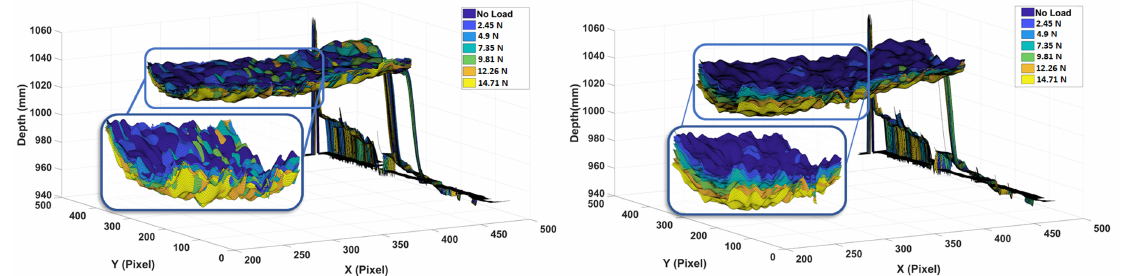
Figure 12. Wing deflections due to loads placed at ( Left ) Position 1 ( Right ) Position 8.